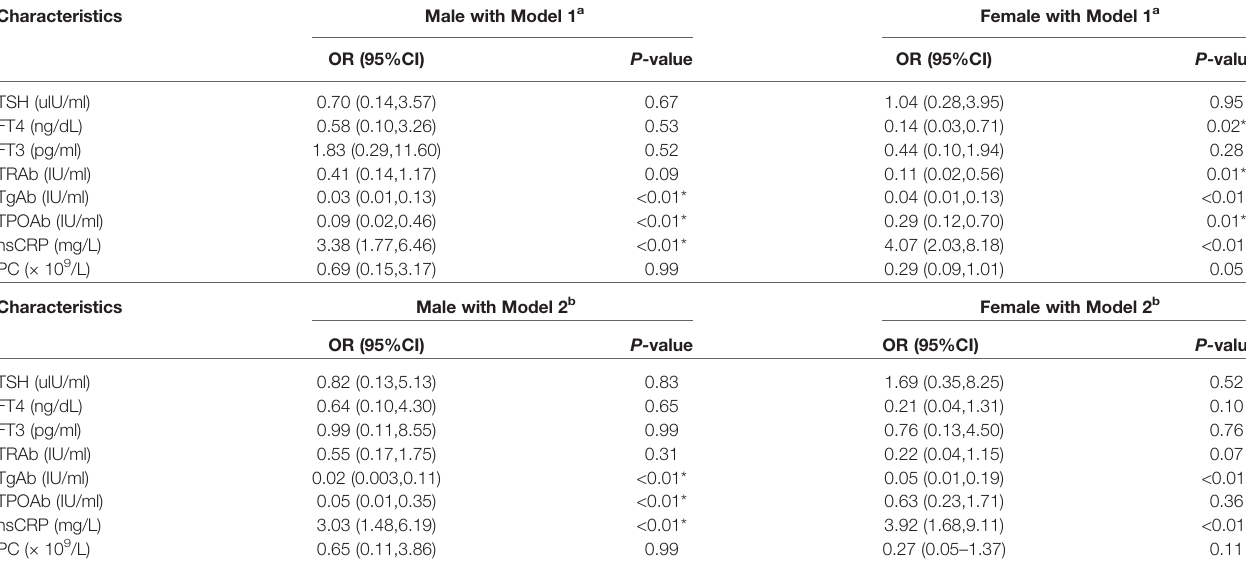
TABLE 2 | Logistic regression analysis for the risks of metabolic dysfunction associated fatty liver disease (MAFLD).